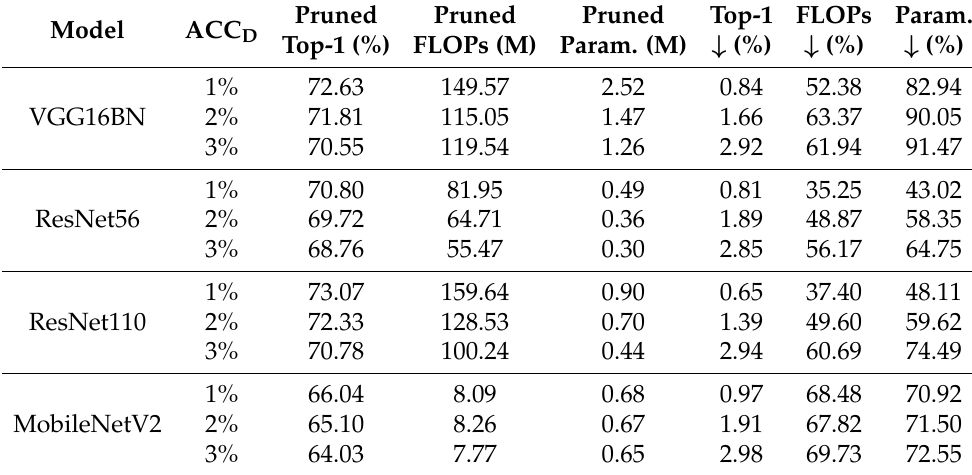
Table 3. Pruning results of the experiments on